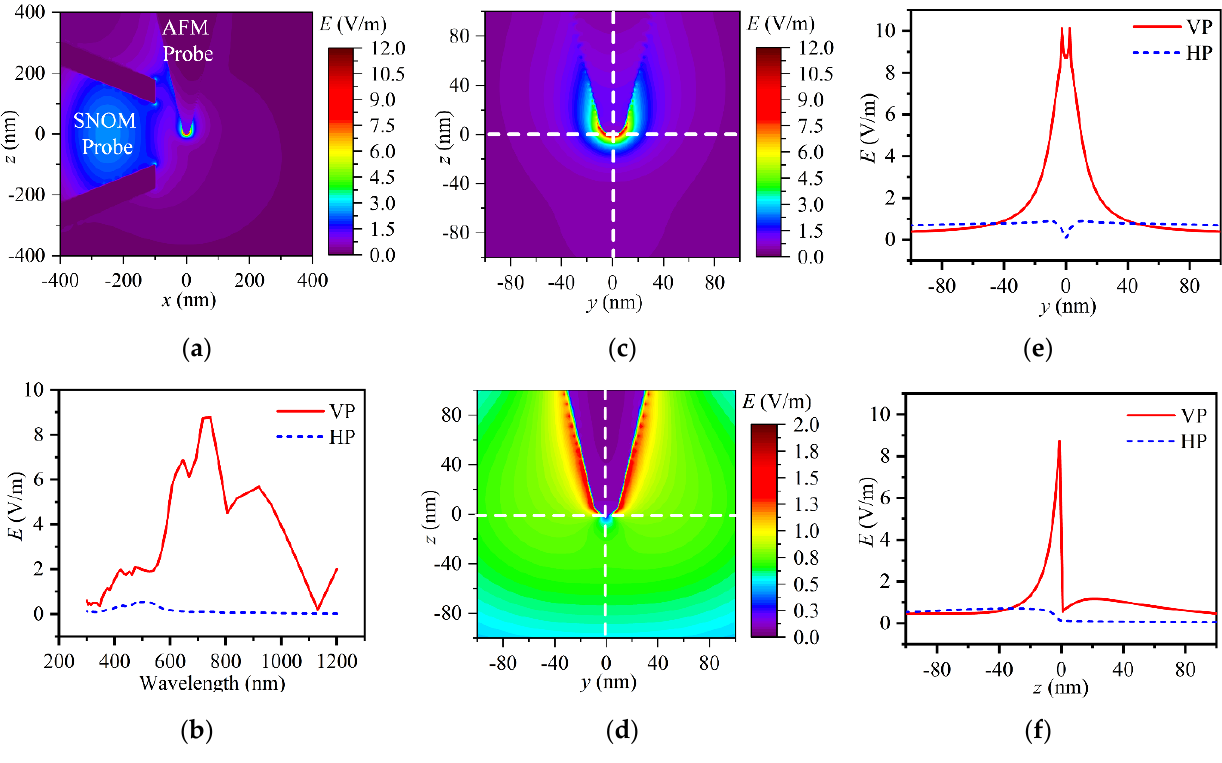
Figure 2. Single probe irradiated by polarized near-field laser coming from an SNOM probe. ( a ) Distributions of electric field around two probes induced by VP laser; ( b ) Electric intensities at the end of probe tip versus wavelengths of incident VP and HP laser. Distributions of electric fields in y-z plane induced by VP laser ( c ) and HP laser ( d ) with wavelength of 717 nm; Corresponding distributions of electric field along y -axis ( e ) and z -axis ( f ).